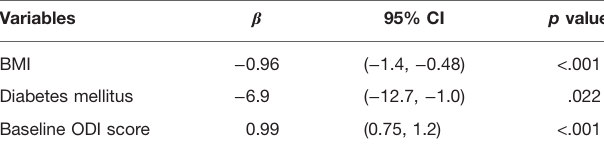
TABLE 5 | Signi fi cant predictors of 24-month Δ ODI score for DLS-I-LSS.